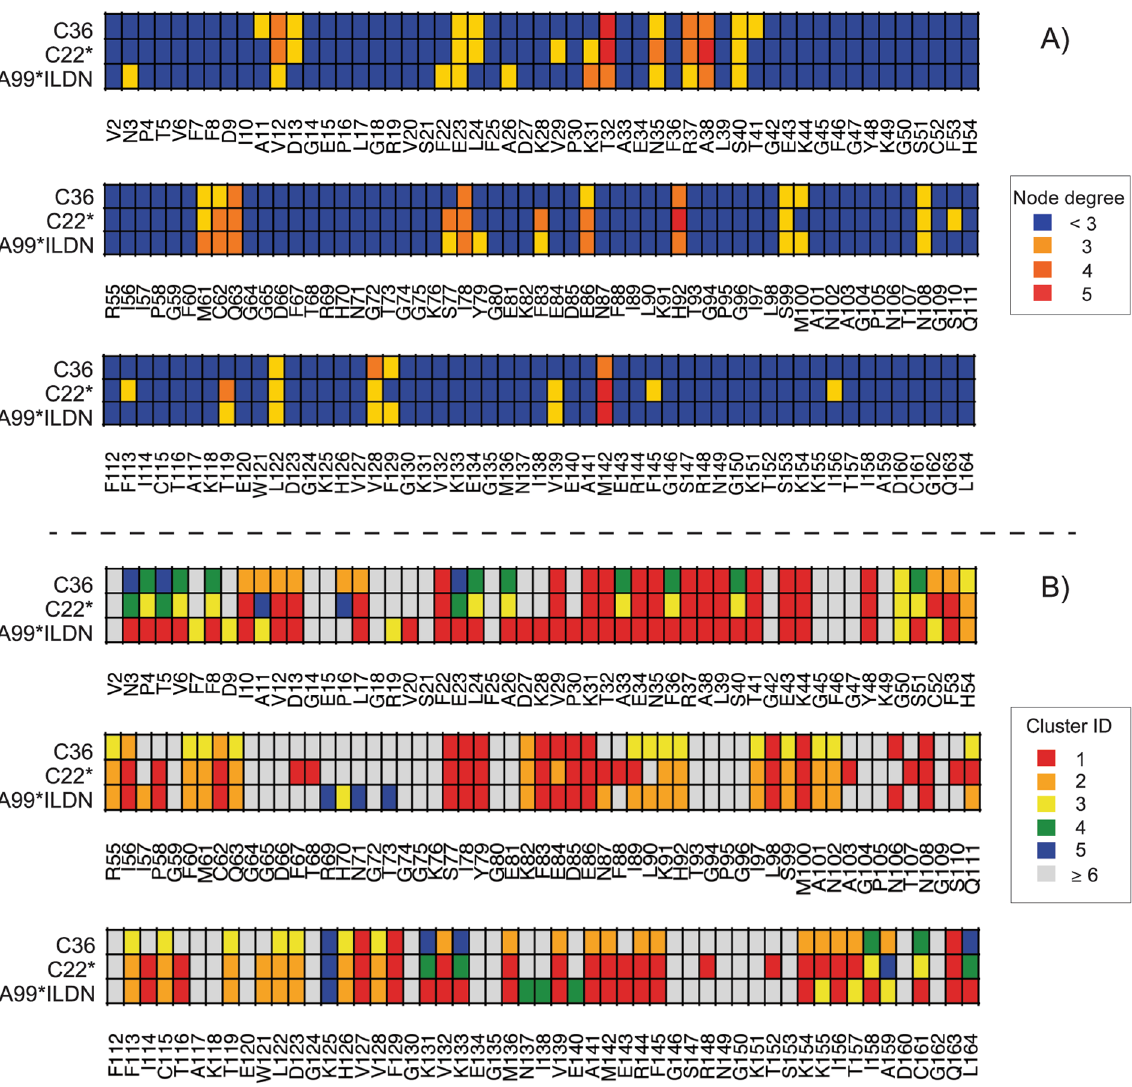
Figure 6. Heatmaps comparing hubs and connected components of CypA MD simulations. We used heatmaps to show the hubs ( A ) and the connected components (i.e. clusters) ( B ) identified in CypA MD simulations with the three different force fields CHARMM22 * (C22 * ), CHARMM36 (C36) and Amber99SB * -ILDN (A99 * ILDN). This representation allows to identify changes in node degree or in the cluster where a node is located at the residue-level.